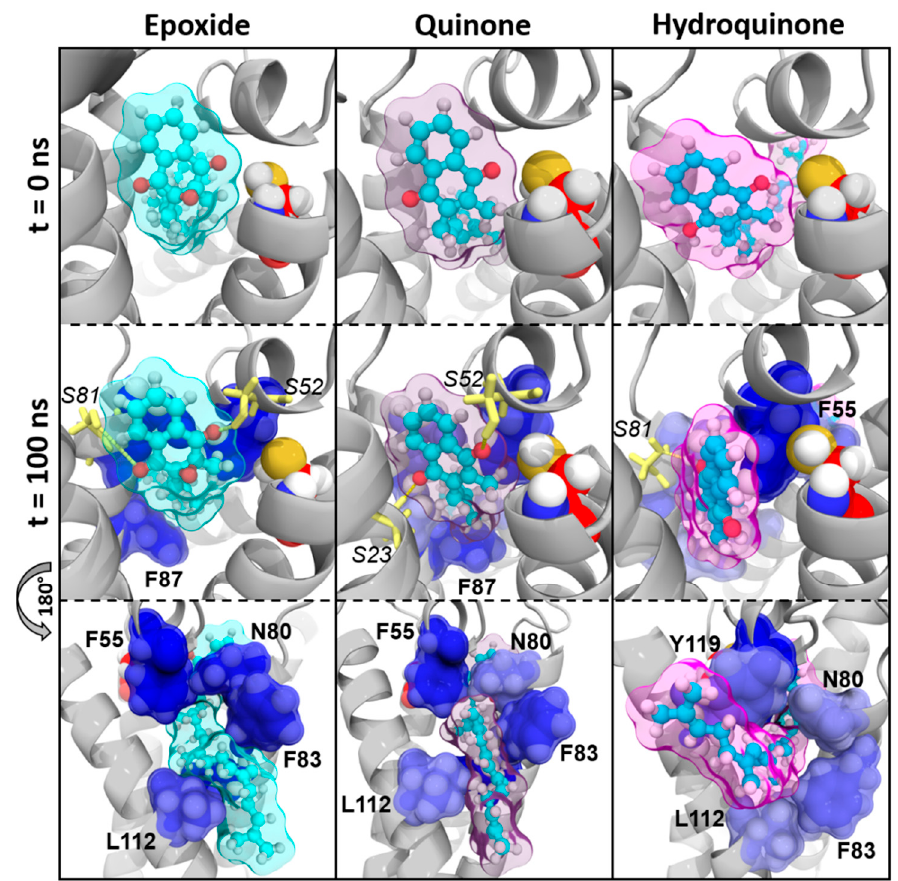
Figure 4. Vitamin MK4 interactions with vitamin K epoxide reductase (VKORC1) in molecular dynamics (MD) simulations. Vitamin MK4 is shown as cyan sticks and spheres; the transparent surface is colored as cyan, violet and pink for epoxide, quinone, and hydroquinone states of vitamin MK4, respectively. The VKORC1 protein structure is depicted as a grey image; the C135 residue is presented as red spheres. Oxygen, nitrogen, sulfur, and hydrogen atoms are colored in red, blue, yellow, and white, respectively. VKORC1 residues involved in hydrogen bonds with vitamin MK4 are shown as yellow sticks (hydrogen bonds are depicted as yellow dashes) and numbered in italic characters. VKORC1 residues contributing to vitamin MK4–VKORC1 binding free energy are presented as blue spheres and a transparent surface (the darker the blue is, the stronger the interaction is) and numbered in bold characters.